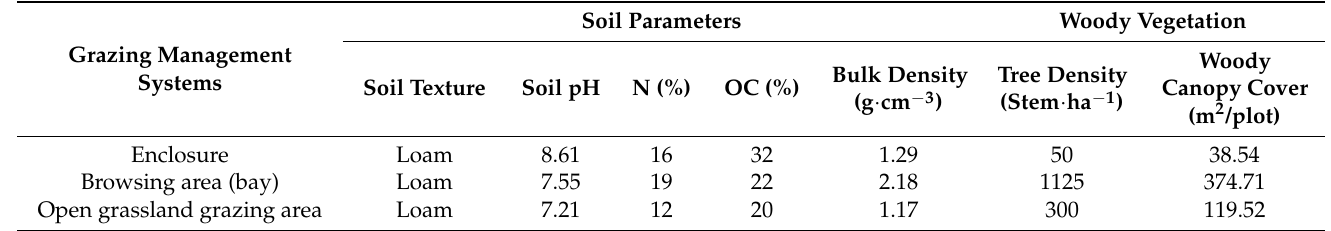
Table 1. Soil and vegetation parameters under customary grazing management systems in eastern